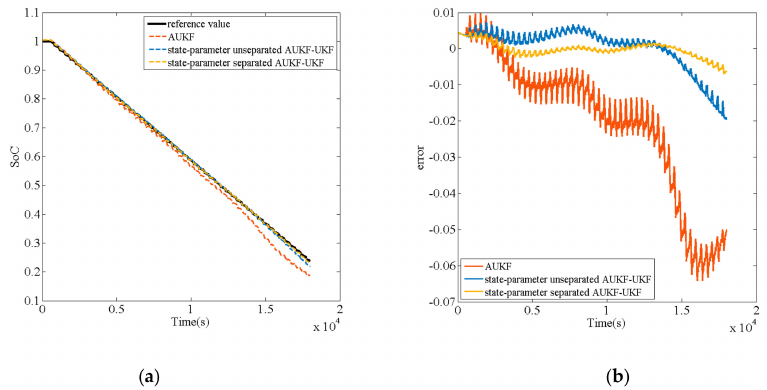
Figure 15. ( a ) The comparison of the SoC estimation between three algorithms under DST test; ( b ) The comparison of the SoC estimation error between three algorithms under DST test.